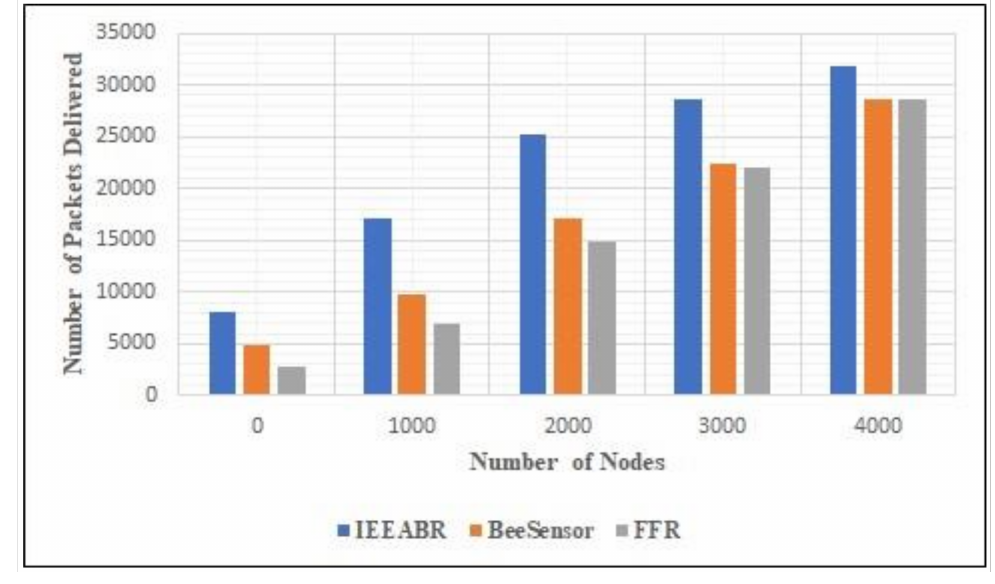
Figure 12. Total packets delivered.